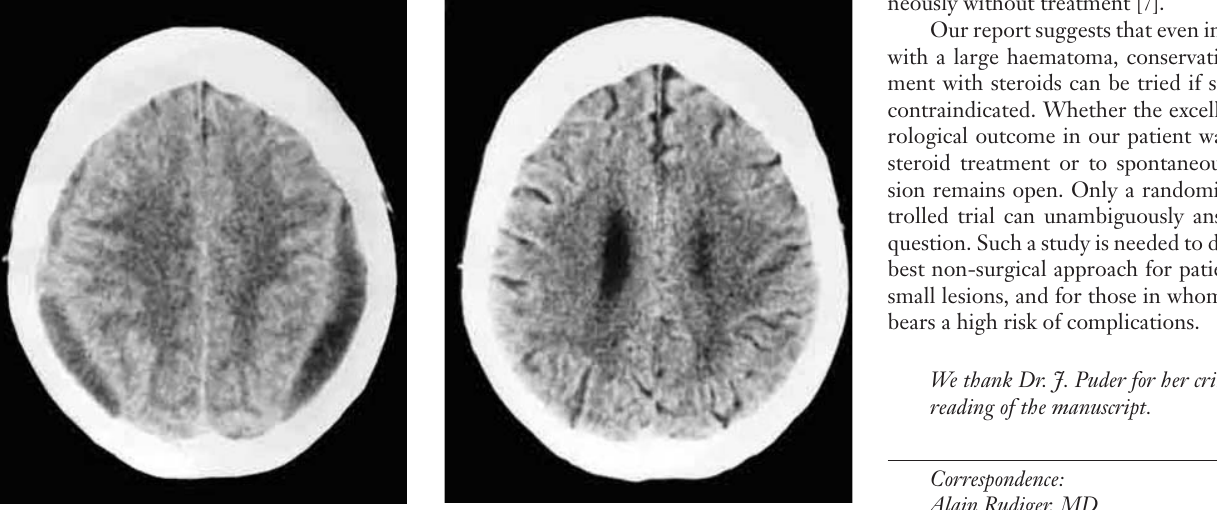
Computerised tomography scan of the brain six weeks later showing complete resolution without surgical therapy.